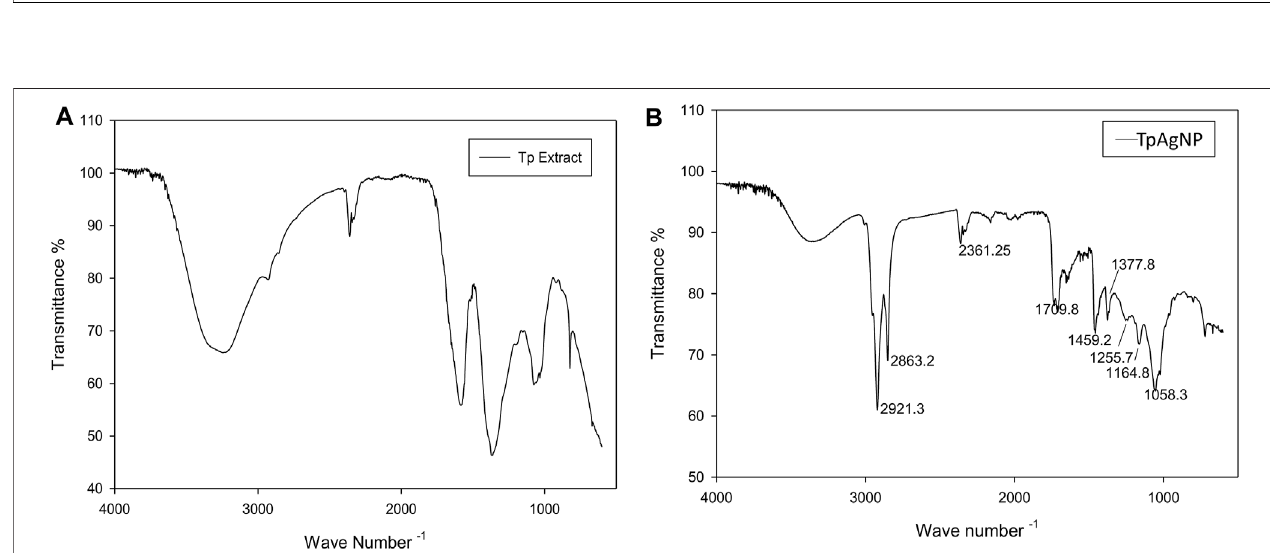
Frontiers in Bioengineering and Biotechnology |